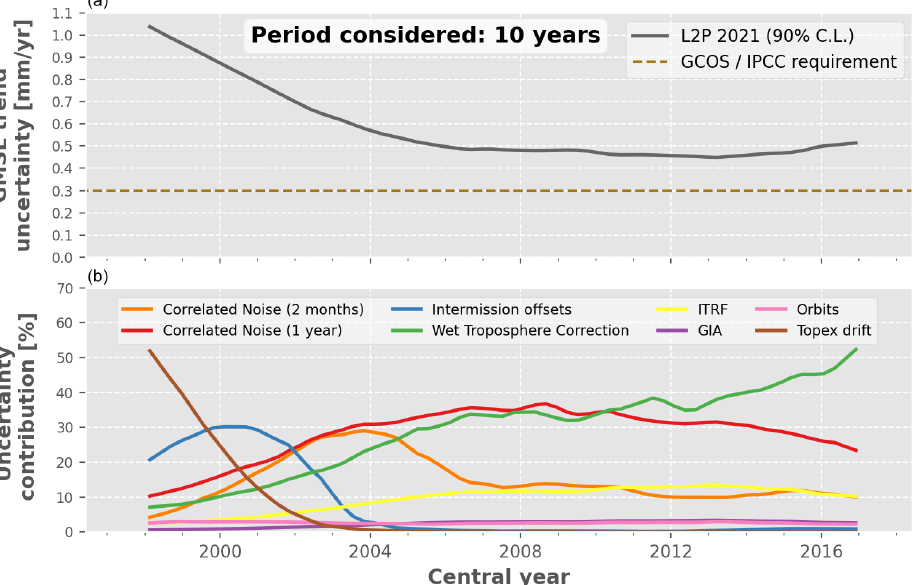
Figure 8. Relative contribution of each uncertainty budget contributor to the GMSL trend uncertainty over periods of 10 years. (a) GMSL trend uncertainty in the L2P21 record. The horizontal dashed brown line shows the GCOS/IPCC requirement for the GMSL trend stability, i.e. 0.3myr − 1 (90%C.L.). (b) Relative contribution to the total GMSL trend uncertainty (%) of each uncertainty budget contributor, i.e. the altimeters, the radiometers, the orbit determination and the geophysical corrections.